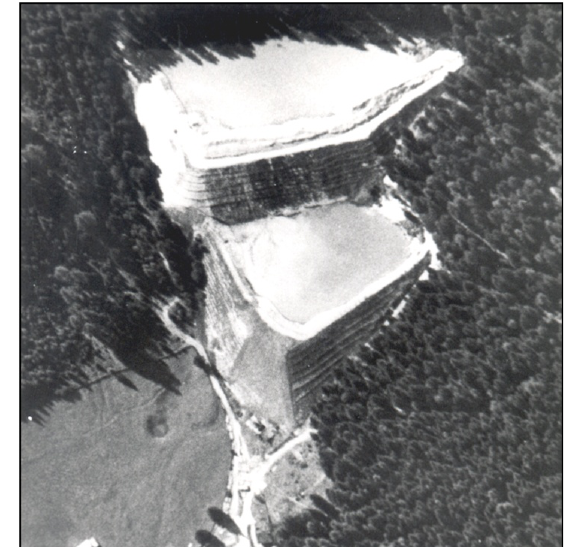
Fig. 4 – The embankments of the landfill minings are made through a process of centrifugation in a hydrocyclone in which are channeled the mud; sand is separated and used to realize the embankment, while the finer fraction, constituted by silty mud to settle, is discharged into the reservoir through a pipe (from Watermeyer and